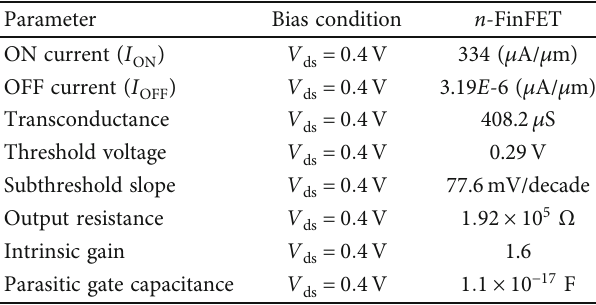
Table 2: Analog performance parameters towards n -type 16 nm SOI FinFET